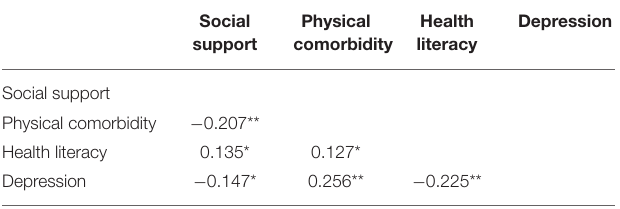
TABLE 3 | The correlation among key variables.